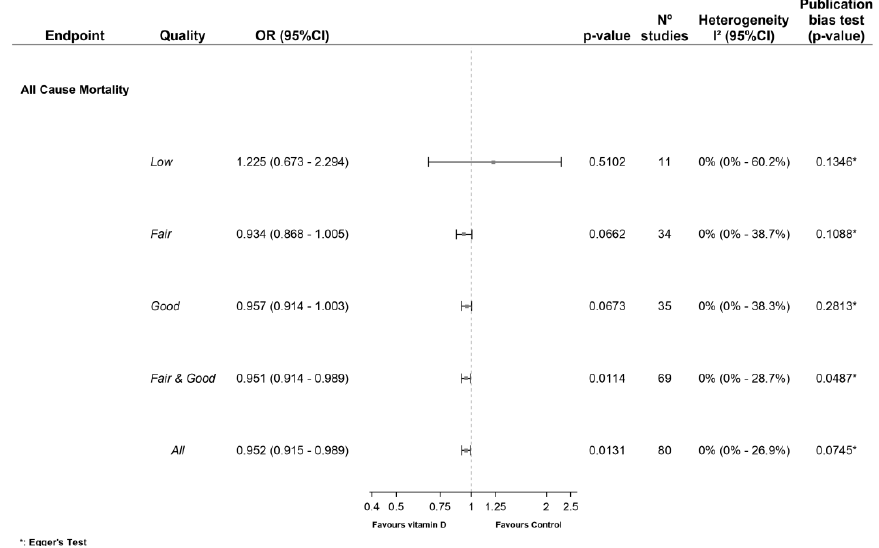
Figure 3. Effect of vitamin D supplementation on cardiovascular and non-cardiovascular mortality. ( A ) Forest plot of cardiovascular mortality. ( B ) Forest plot of non-cardiovascular mortality.